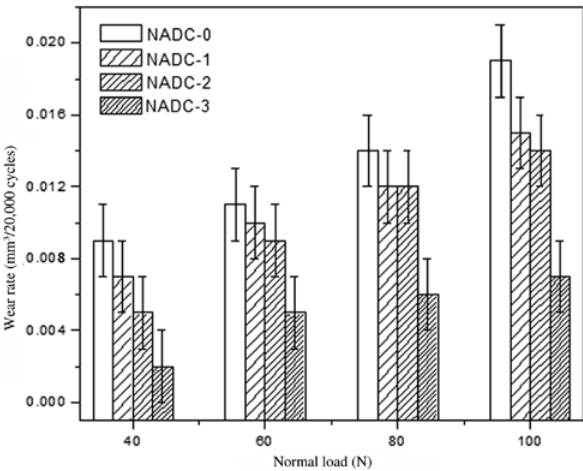
Figure 3: Effect of normal load on volumetric wear rate of the dental composites in food slurry condition (at constant chewing speed of 5 mm/s and chamber temperature of 25 ° C).